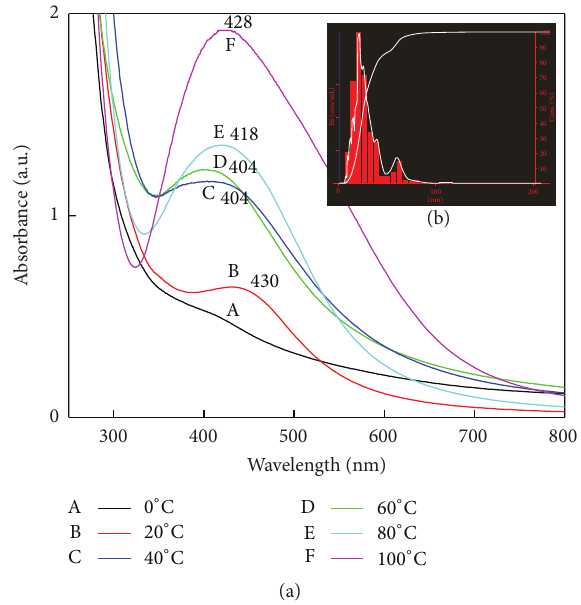
Figure 7: Effect of temperature on size of SNPs: (a) UV-Vis spectral analysis shows reduction of SNPs. A: 0 ∘ C, B: 20 ∘ C, C: 40 ∘ C, D: 60 ∘ C, E: 80 ∘ C, and F: 100 ∘ C. Spectrum C and spectrum D have the blue shift which indicates the small size of synthesized SNPs. Spectrum F asymmetric spectra indicate the aggregation of particles at high temperature. ((b) inset) Particle size distribution by NTA of sample prepared at 60 ∘